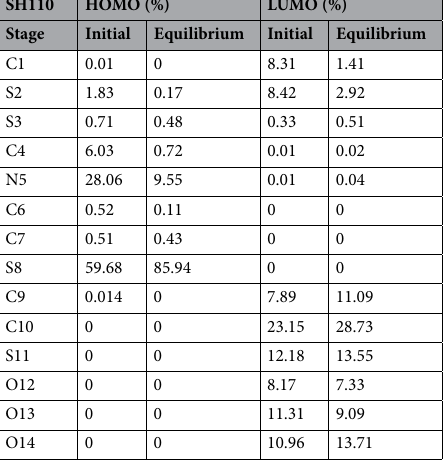
Table 5. Components of SH110 molecular